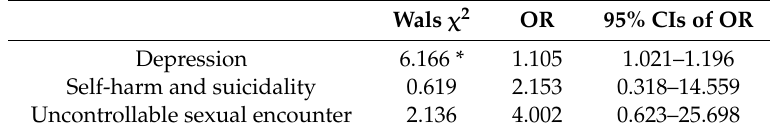
Table 2. Predictors for incidence of internet addiction: logistic regression